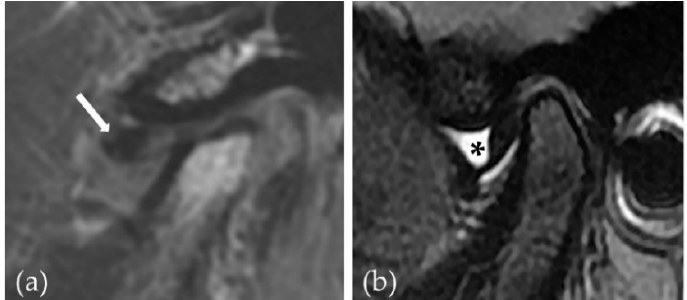
Figure 2. Magnetic resonance imaging (MRI) findings: ( a ) disc deformity and disc derangement (arrow); and ( b ) joint effusion (asterisk).